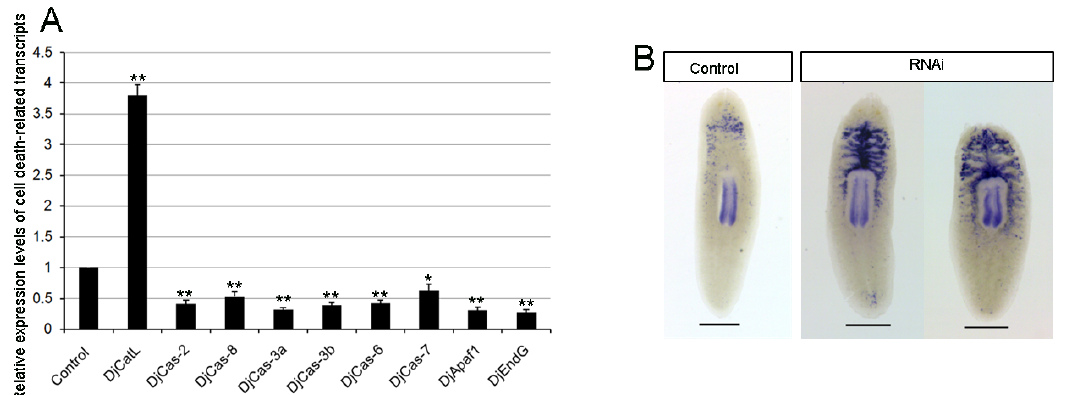
Figure 11. Effects of RNAi- Djhsp60 on the expression of cell death-related transcripts. ( A ) Relative expression levels of cell death-related transcripts detected by qRT-PCR. Asterisks indicate statistical differences (* p < 0.05, ** p < 0.01). ( B ) Expression pattern of DjCatL after RNAi revealed by WISH. Color development for 45 min for this experiment. If color was developed for 2 h, CatL transcripts were distributed in intestinal system from head to tail, n = 5 animals. Scale bar: 0.5